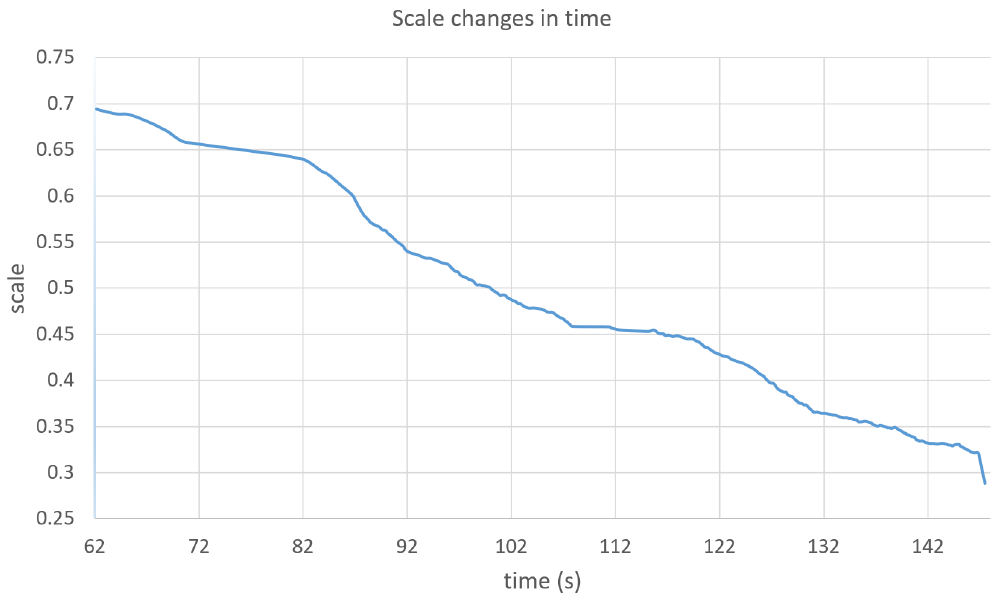
Figure 15. Scaling factor changes in the Sirtaki example as a consequence of tempo changes. The tempo changes from roughly 90 to 210 beats per minute, causing the scale of part on layer L 6 to change from 0.7 to